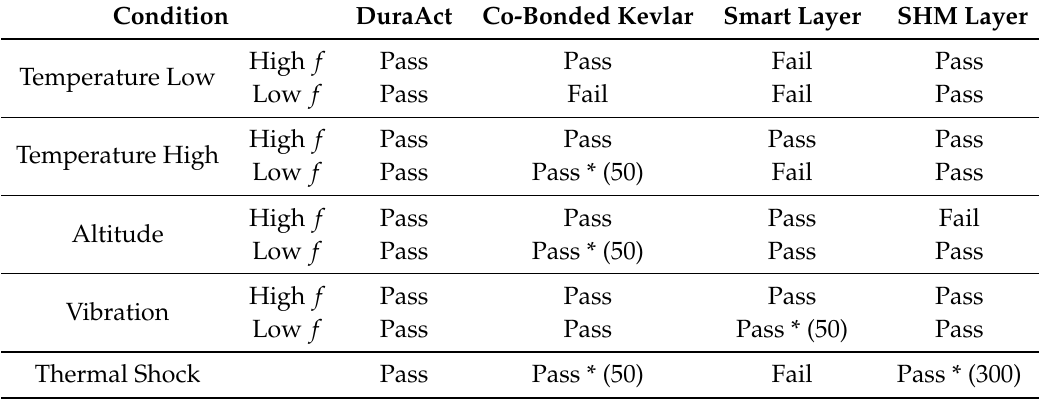
Table 2. Robustness and integrity results for environmental tests. Pass indicates integrity at all frequencies in range. * integrity in all but one frequency in bracket. Low f : 50, 75, 100, 150; High f : 200, 250, 300